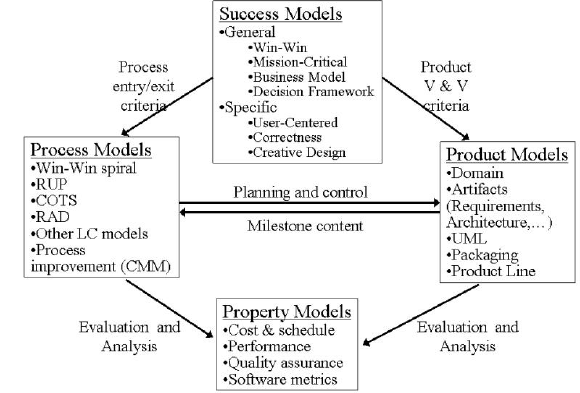
Figure 1. Classes of models used in software system engineering